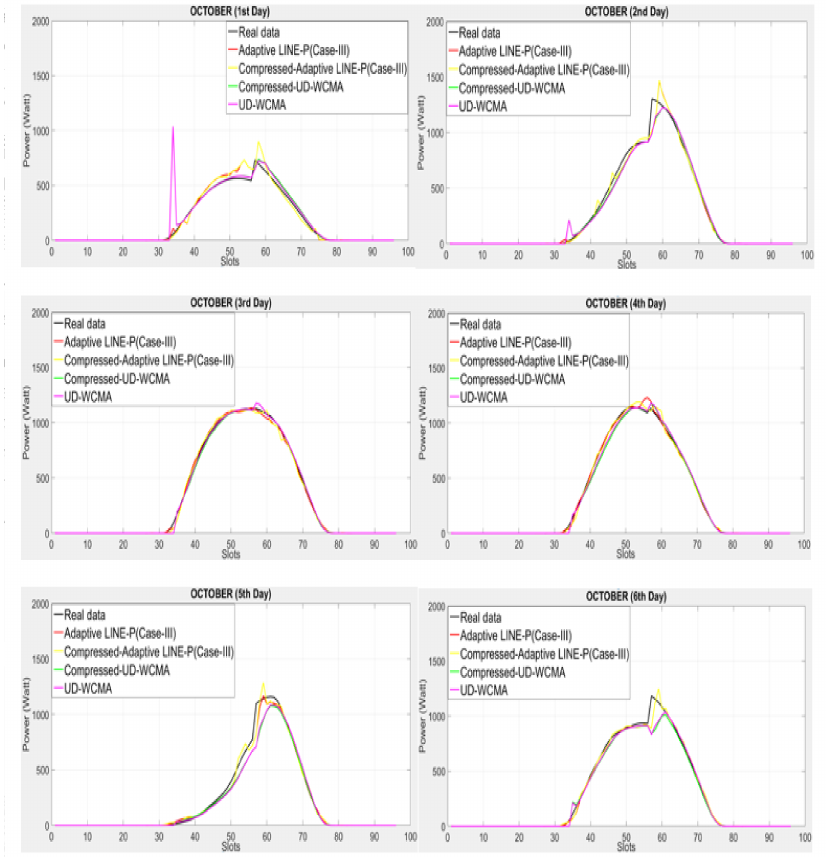
Figure 7. Graphical representation of the compressed profile method against the real data based on the shorter (15-min data interval) time period horizon of solar profile with 96 time slots in 24 h. 5.2. Error Estimation with and without Compression Method in UD-WCMA and Adaptive LINE-P (Case III) for the Solar Energy Profile